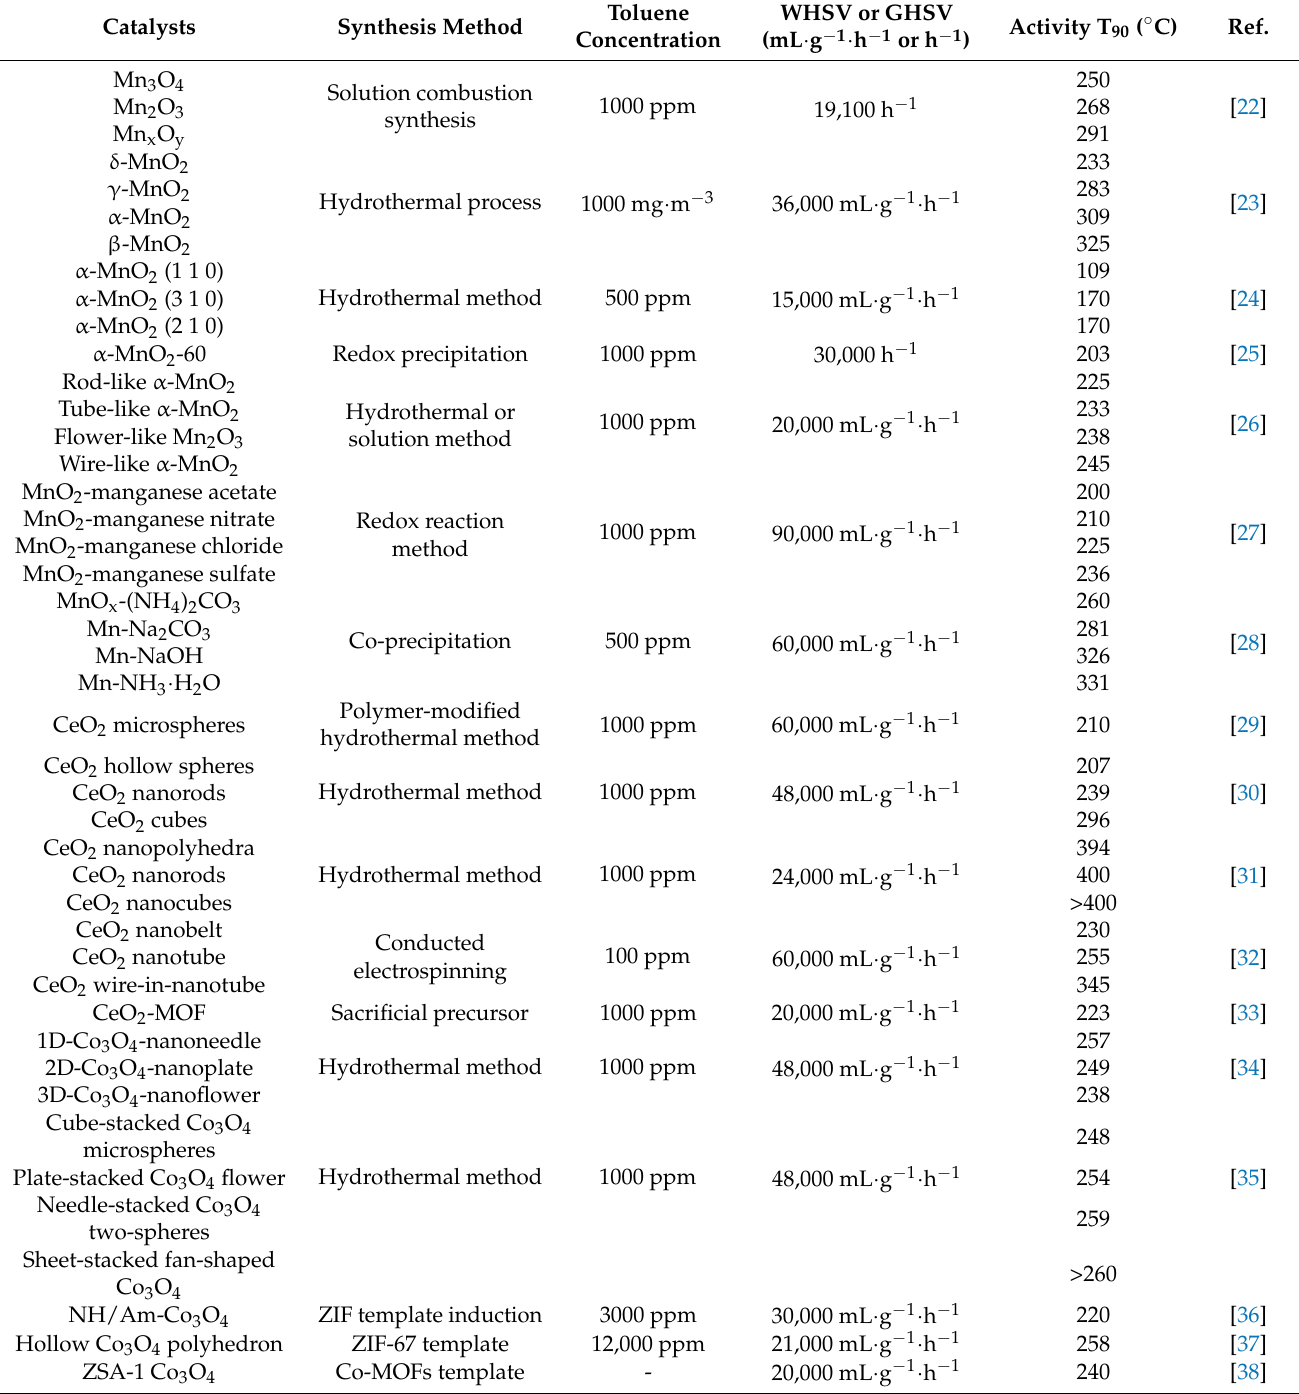
Table 1. Catalytic activity for toluene combustion over single metal oxides reported in the recent